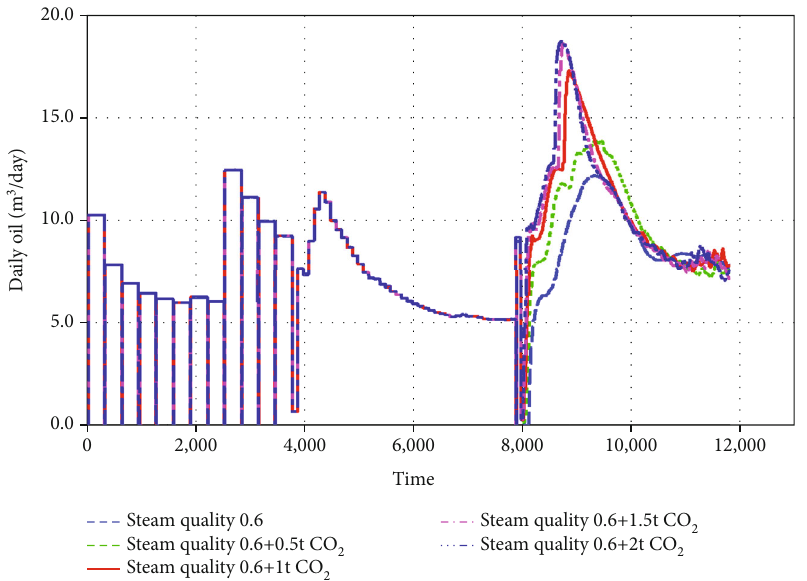
Figure 9: E ff ect of coinjecting di ff erent amounts of CO